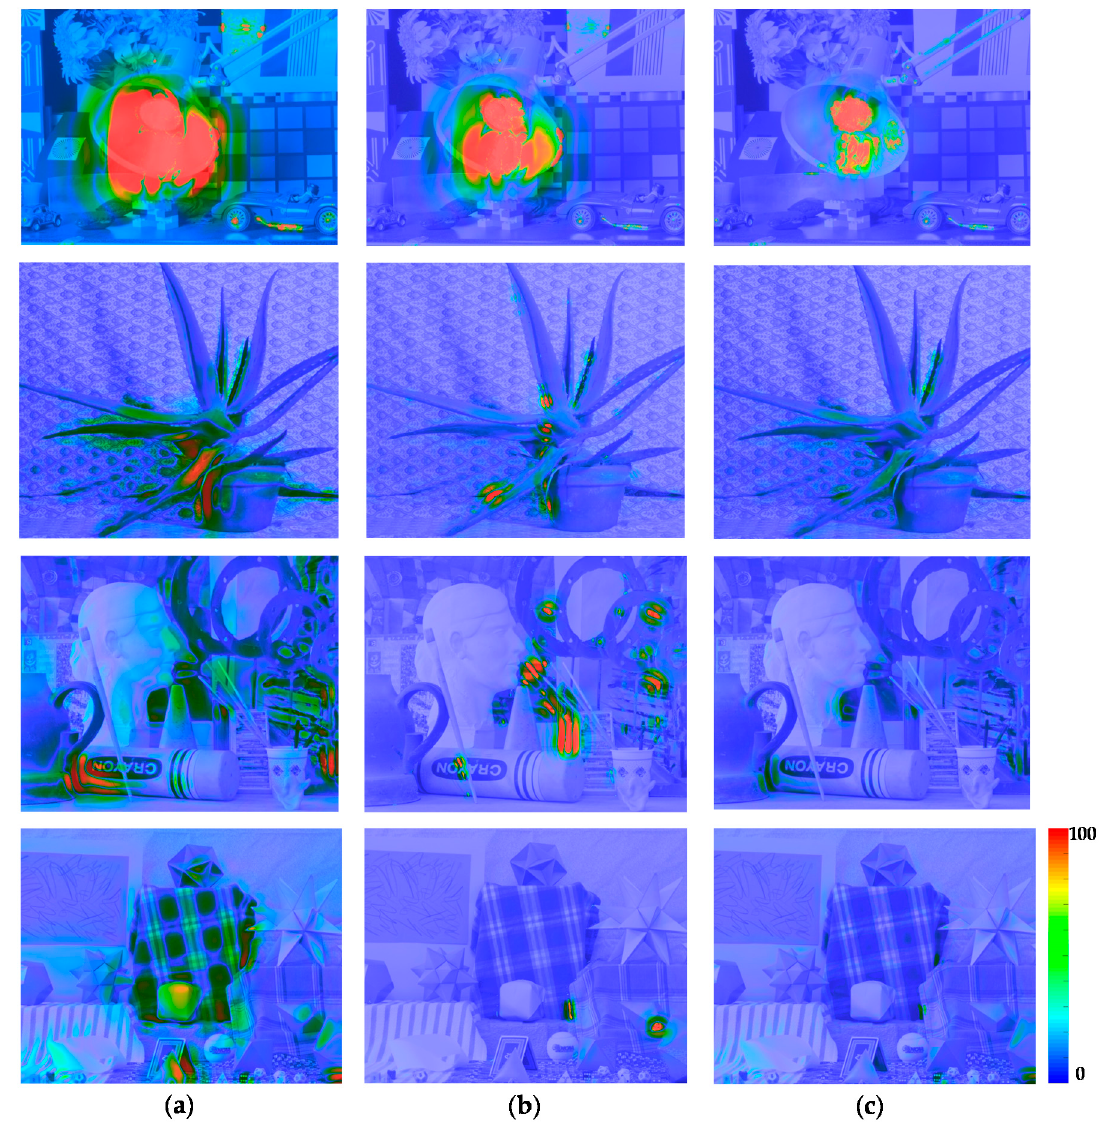
Figure 20. Resultant HDR-VDP2 maps for the Middlebury database and the IIS Jumble dataset with short-long exposure: ( a ) Lin and coworkers’ method [14]; ( b ) Batz and coworkers’ method [16]; and ( c ) proposed method.